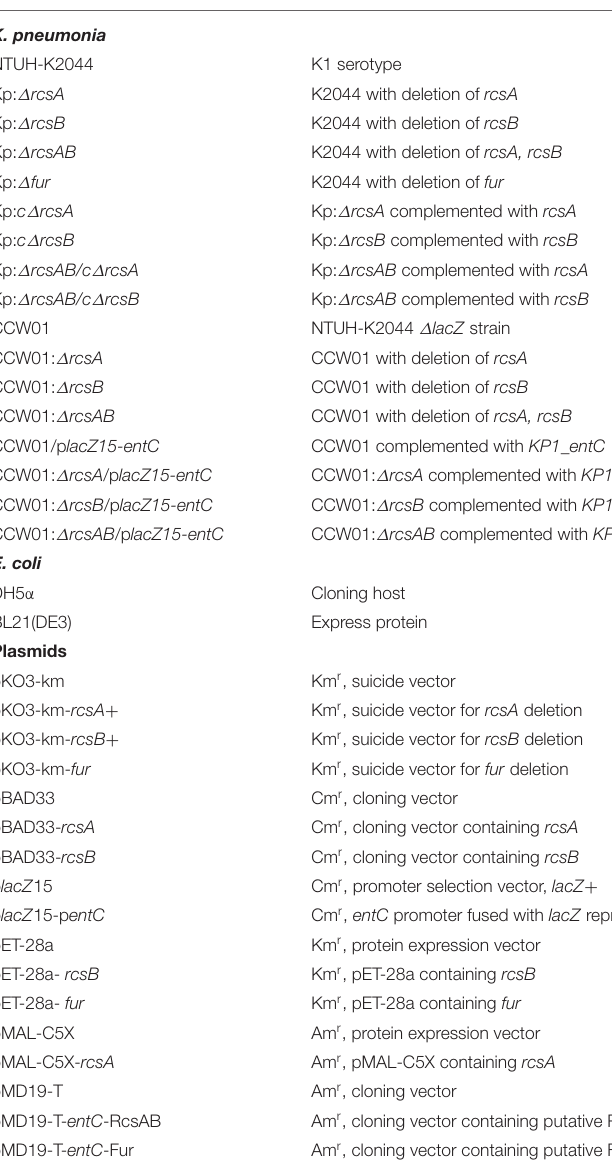
Strains or plasmids Relevant genotype or